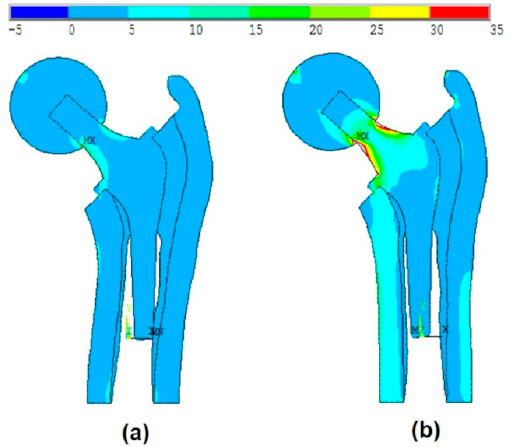
Figure 7. The effect of the introduction of the ball and bone anisotropy on the von-Mises stress distribution at ( a ) the mean point and ( b ) the most probable point